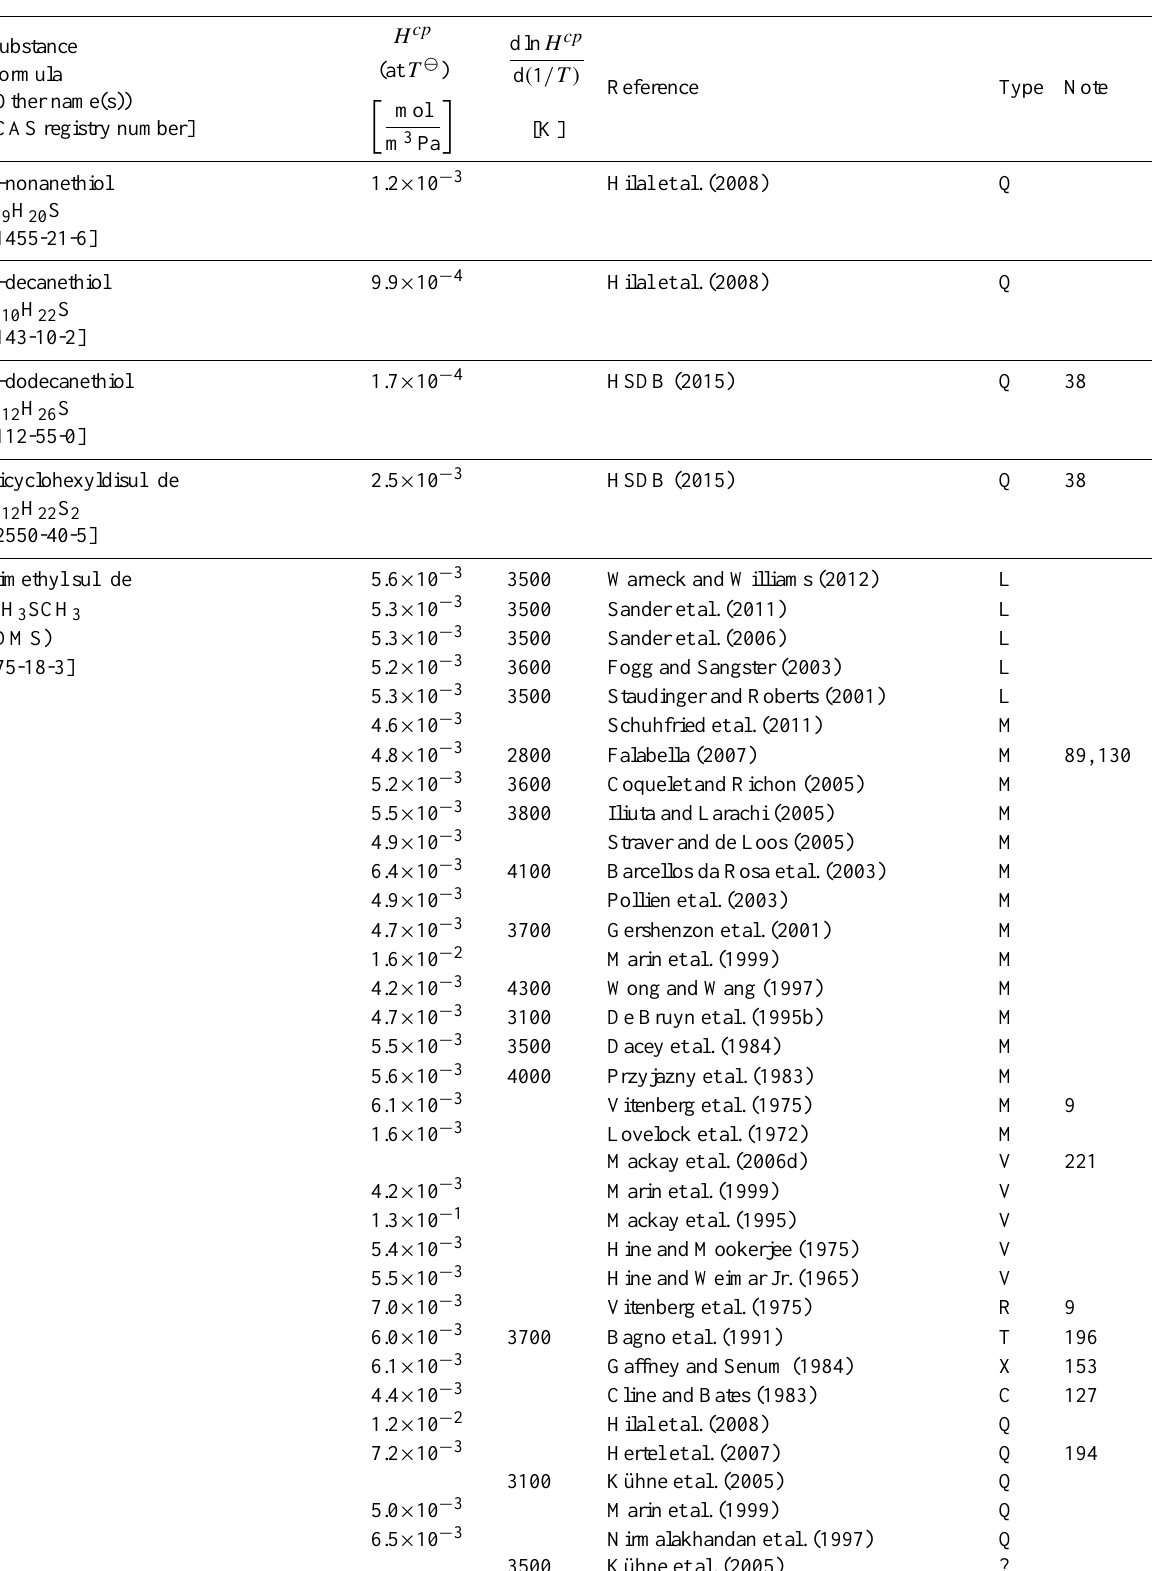
Table 6: Henry’s law constants for water as solvent